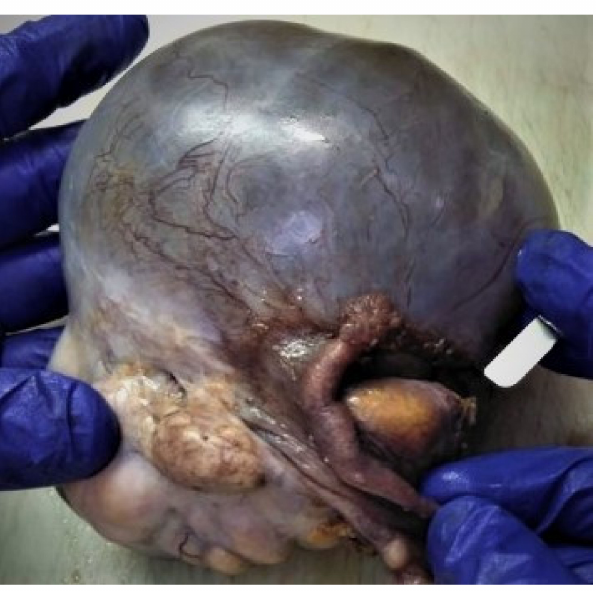
Figure 15. Struma ovarii (courtesy of Dr. M.